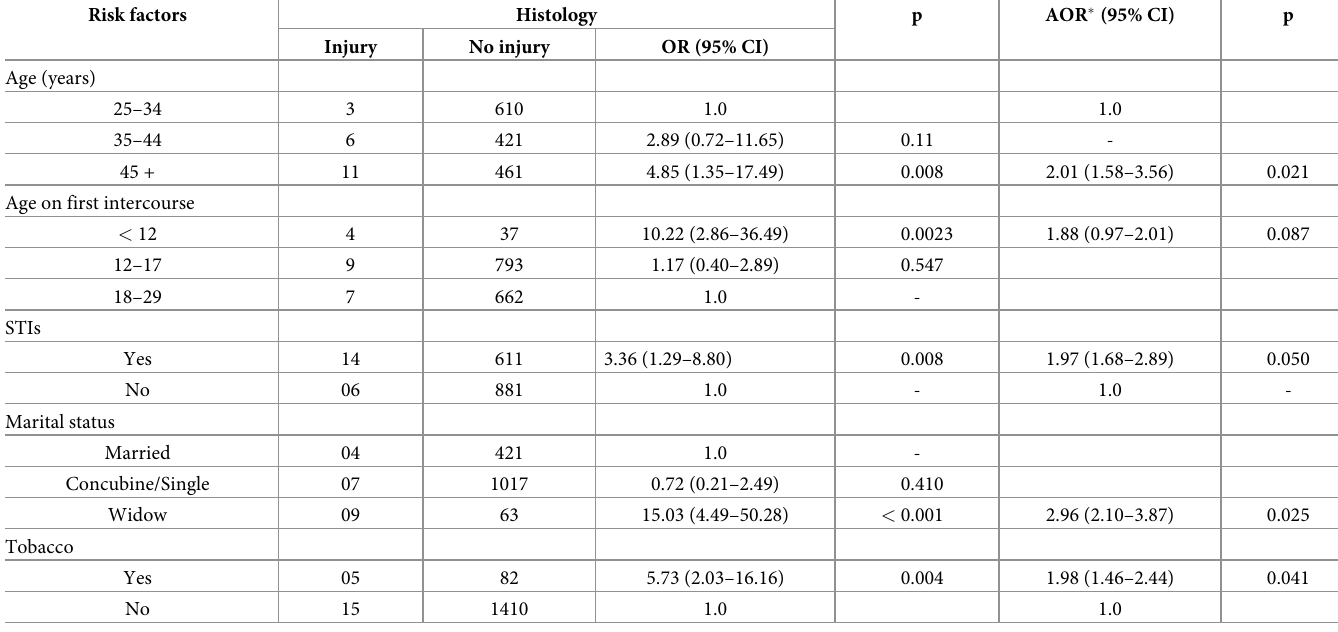
Table 5. Risk factors for cancerous